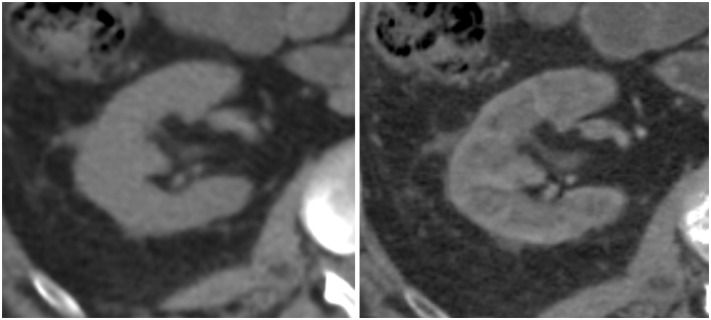
No cortico-medullary differentiation is visible on true unenhanced (TUE) images (left) while virtual unenhanced (VUE) images demonstrate cortico-medullary differentiation (right).Images are displayed using the same CT window width and window level.